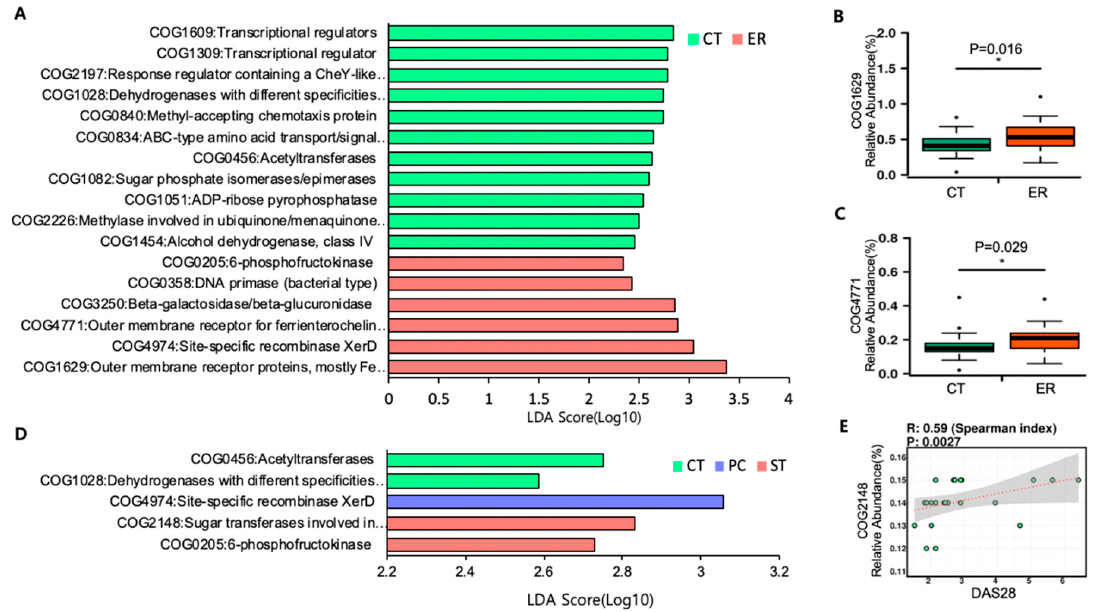
Figure 4. Featured COGs by PICRUSt. ( A ) Differentially abundant COGs between ER and CT groups based on LEfSe analysis. ( B , C ) The relative abundance of COG1629 and 4771. ( D ) Differentially abundant COGs among CT, PC, and ST groups based on LEfSe analysis. ( E ) Spearman correlation analysis of COG2148 and DAS28.